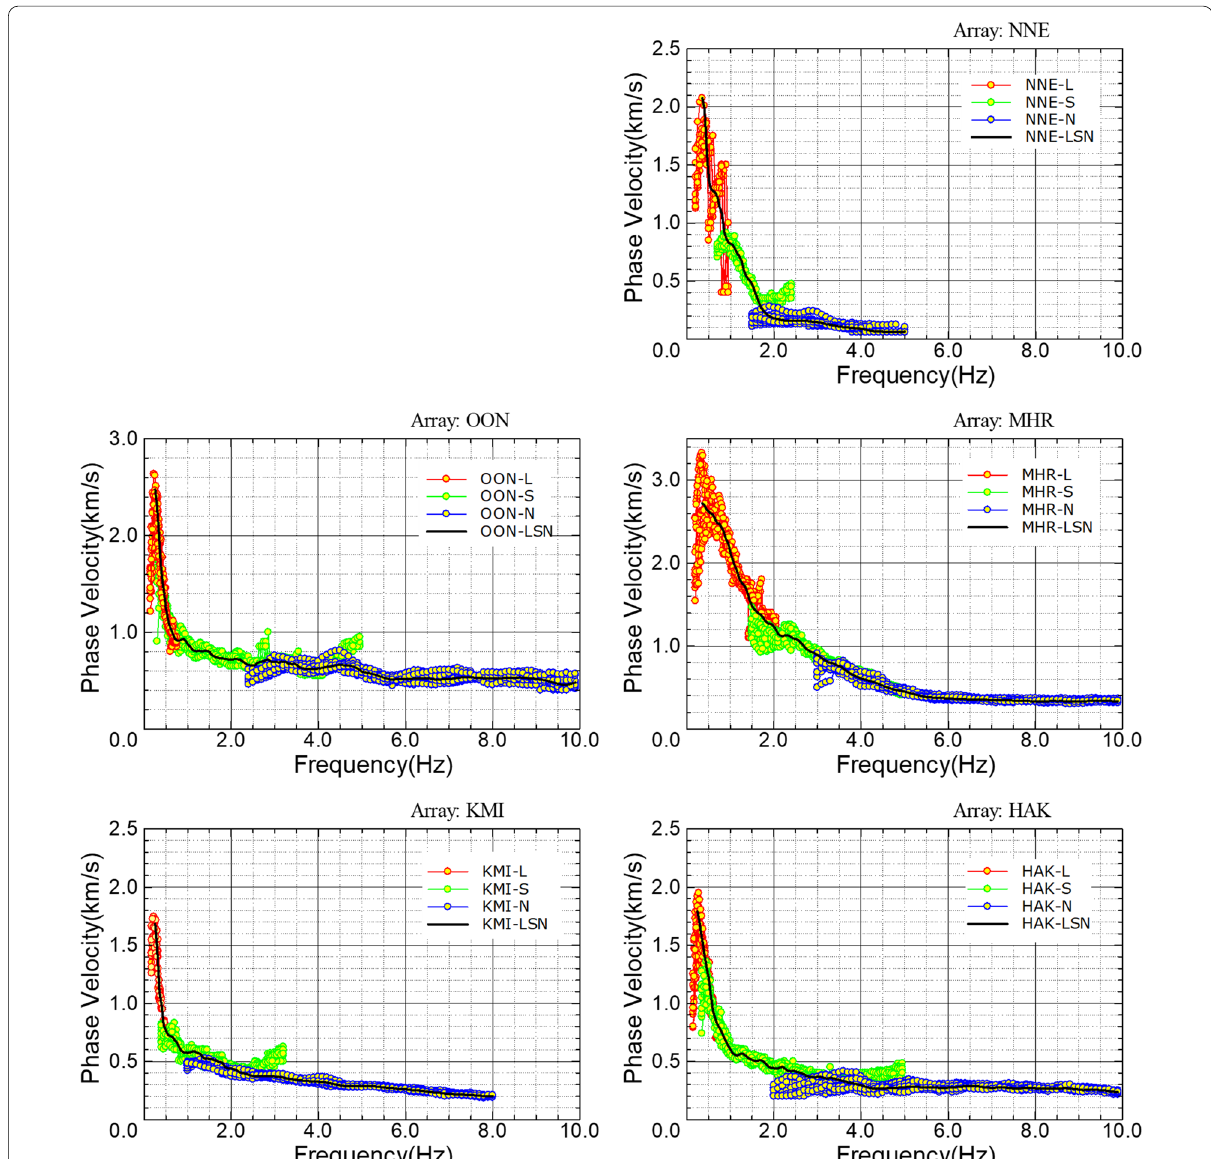
Fig. 2 Observed phase velocities at each site obtained by the SPAC method. The red, green, and blue circles display the measured phase velocities for each dataset from L, S, and N array, respectively. The solid line represents the phase velocity dispersion curve obtained by combining the phase velocities from all datasets of all